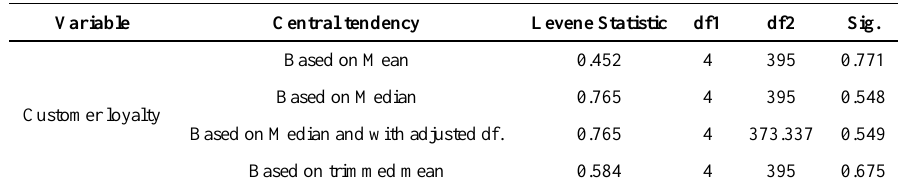
Table 13. Test of Homogeneity of Variances